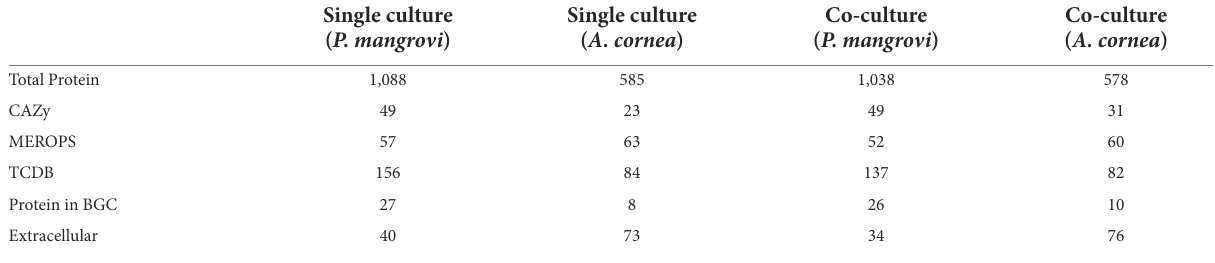
TABLE 1 Number of proteins identified in the single-cultures and co-cultures of Auricularia cornea and Pseudonocardia mangrovi.